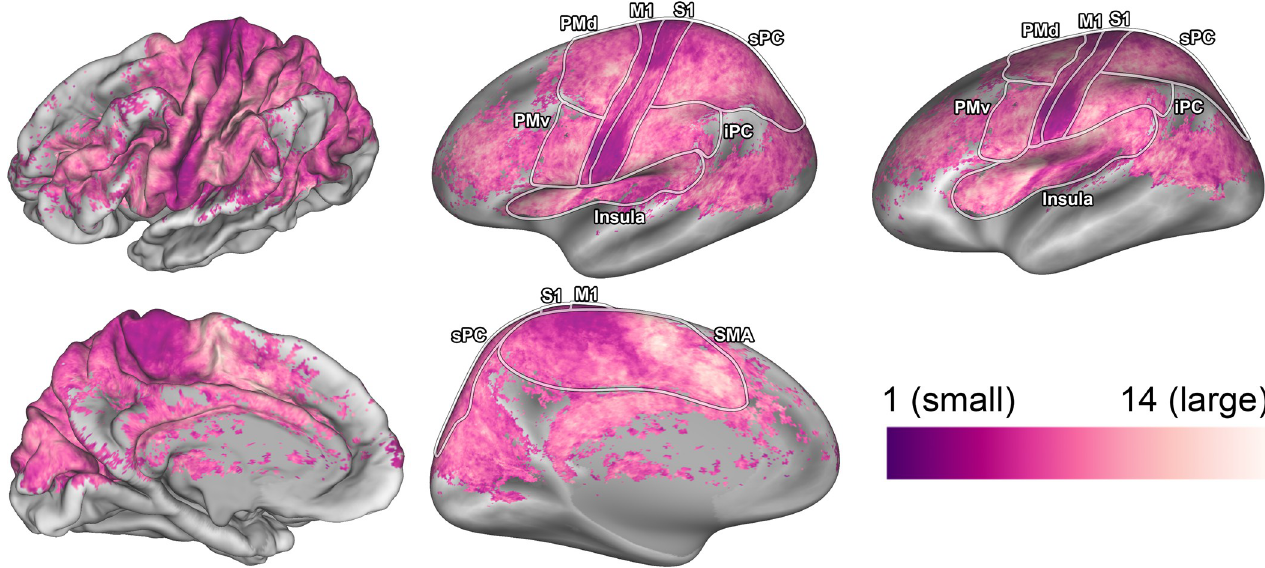
Fig 4. pRF size maps. The pRF size is shown on an average subject pial surface (left) and inflated surface (right) from a lateral point of view (top) and medial point of view (bottom). Colors indicate the pRF size. The ROIs are denoted by the lines drawn on the surfaces: primary motor cortex (M1), primary somatosensory cortex (S1), supplementary motor area (SMA), dorsal premotor cortex (PMd), ventral premotor cortex (PMv), Insula/Sylvian fissure (Insula), inferior parietal cortex (iPC), and superior parietal cortex (sPC). https://doi.org/10.1371/journal.pcbi.1009955.g004 PLOS Computational Biology | https://doi.org/10.1371/journal.pcbi.1009955 April 4,